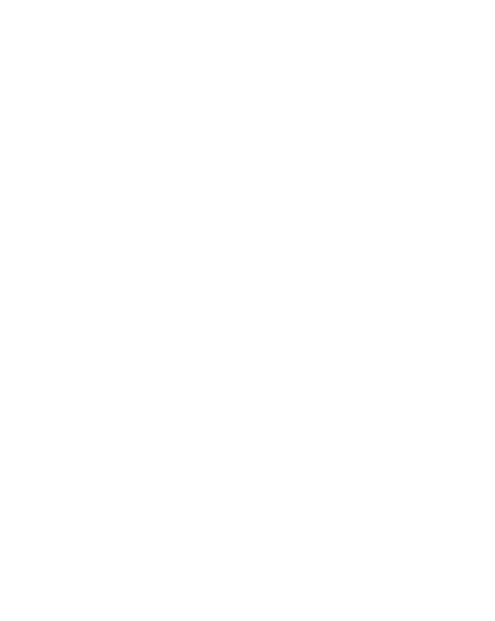
Table 1. Weeks to thresholds for various testing and restriction